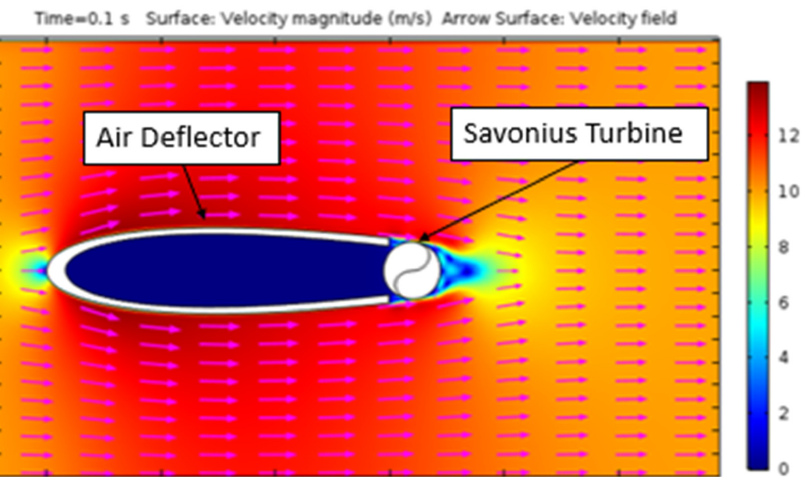
Figure 3. Velocity magnitude plot of the air deflector and area swept by the Savonius turbine. The arrow surface indicates the direction of the wind velocity at each point and the color bar indicates the velocity magnitude at each point.